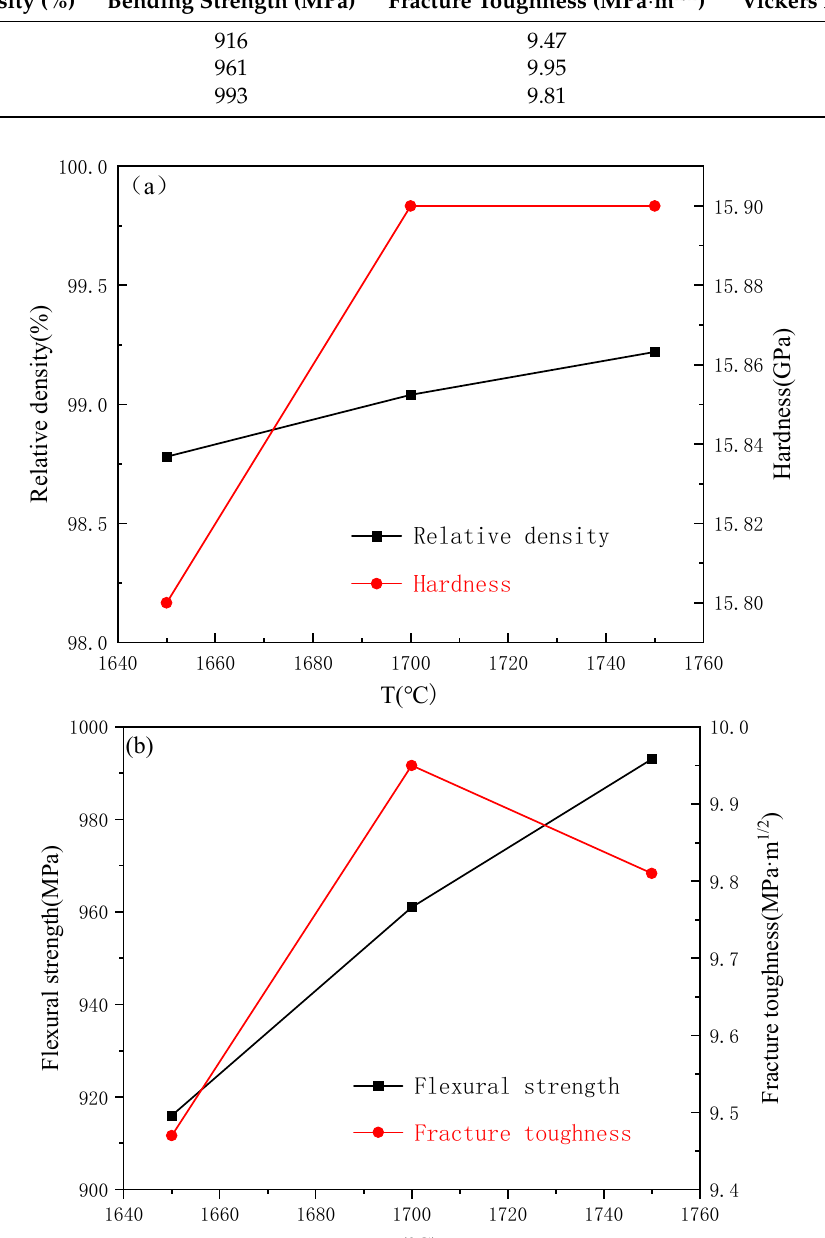
Figure 8. Comparison of performance parameters of SN2, SN4, and SN5 samples at different sintering temperatures: ( a ) Relative density and Vickers hardness; ( b ) Flexural strength and fracture toughness. Table 3. Effect of hot-pressing temperature on the mechanical properties of materials.